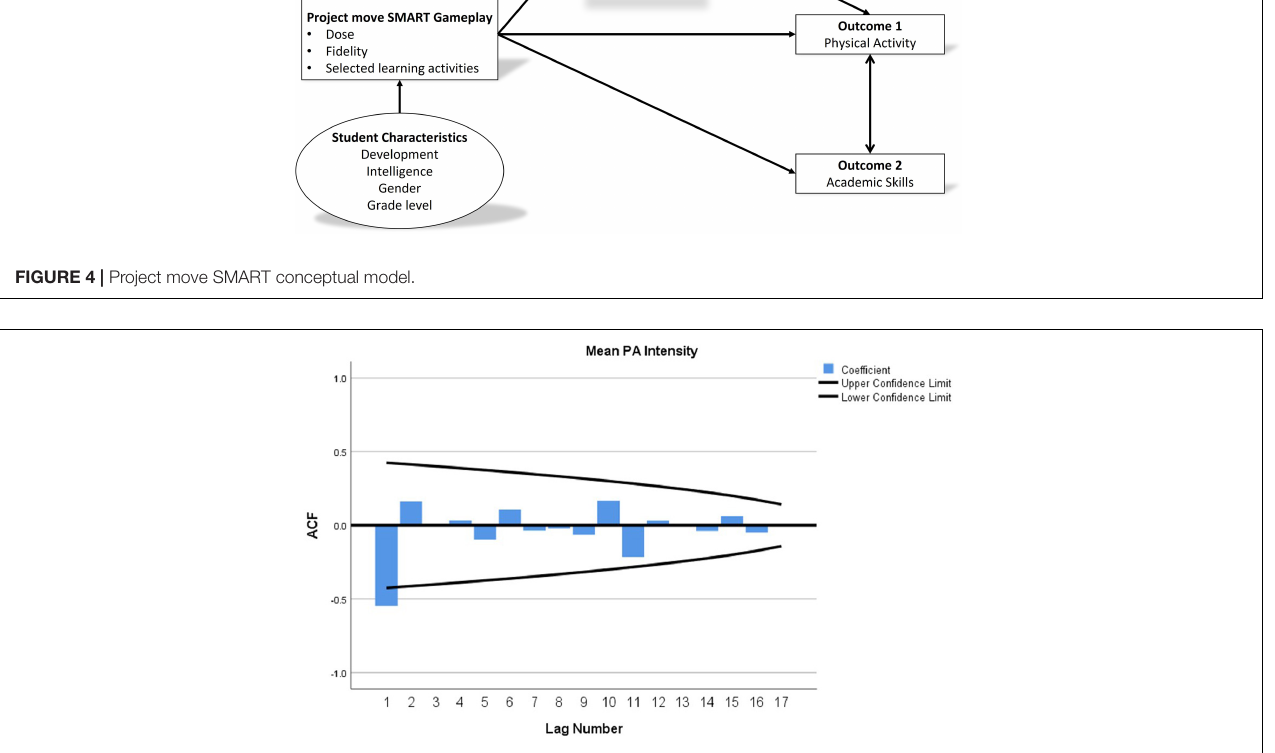
FIGURE 5 | Confidence interval limits of self-reported physical activity